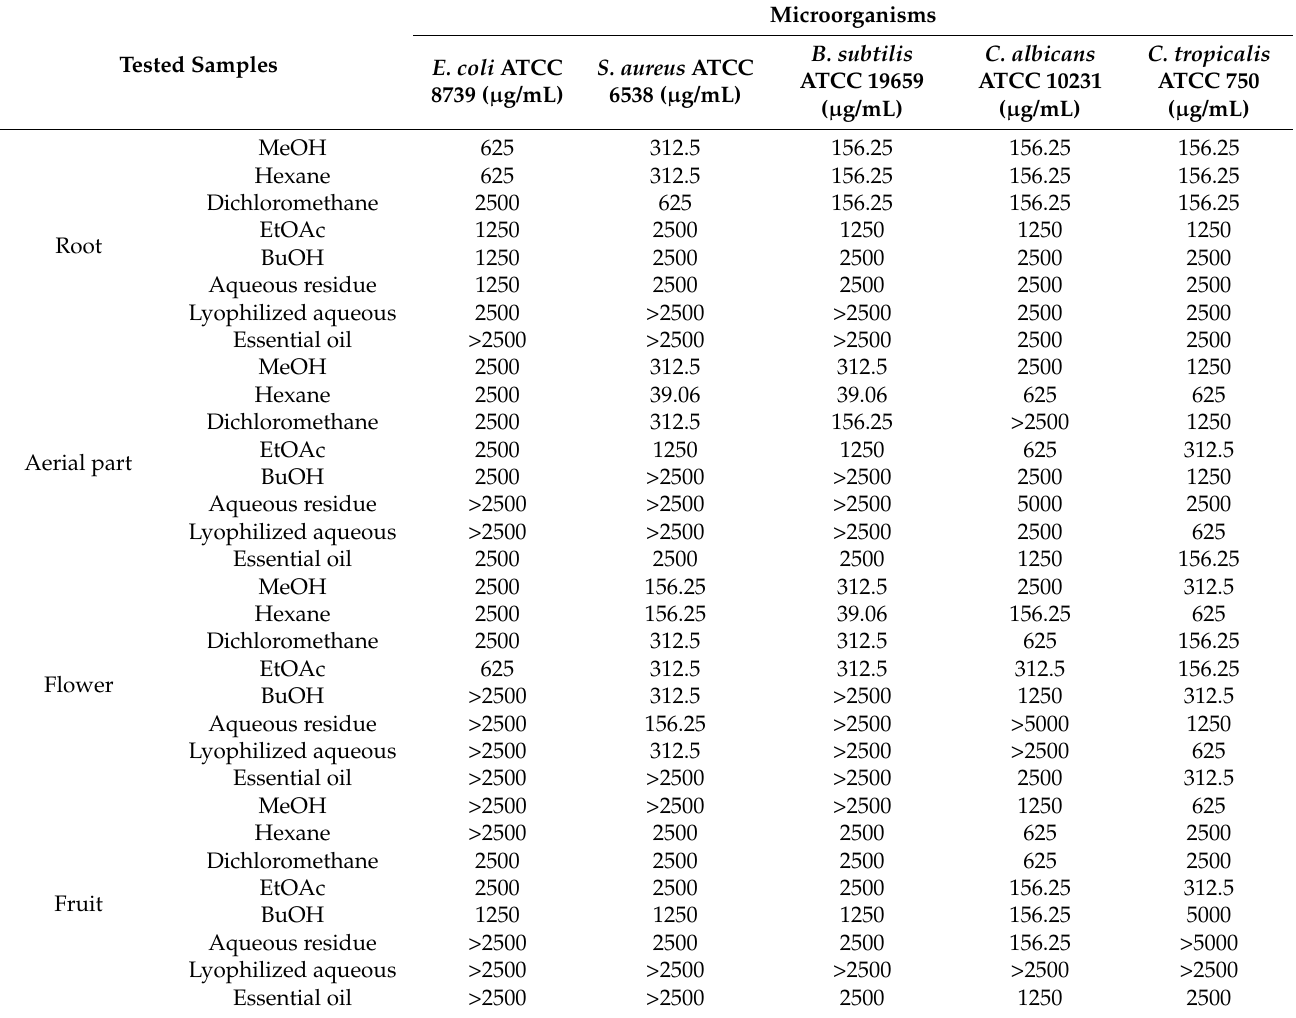
Table 6. The results of antimicrobial activities of the extracts, sub-extracts, essential oils, and ethnob- otanical use from Hypericum scabrum and reference antibiotics (MIC values µ